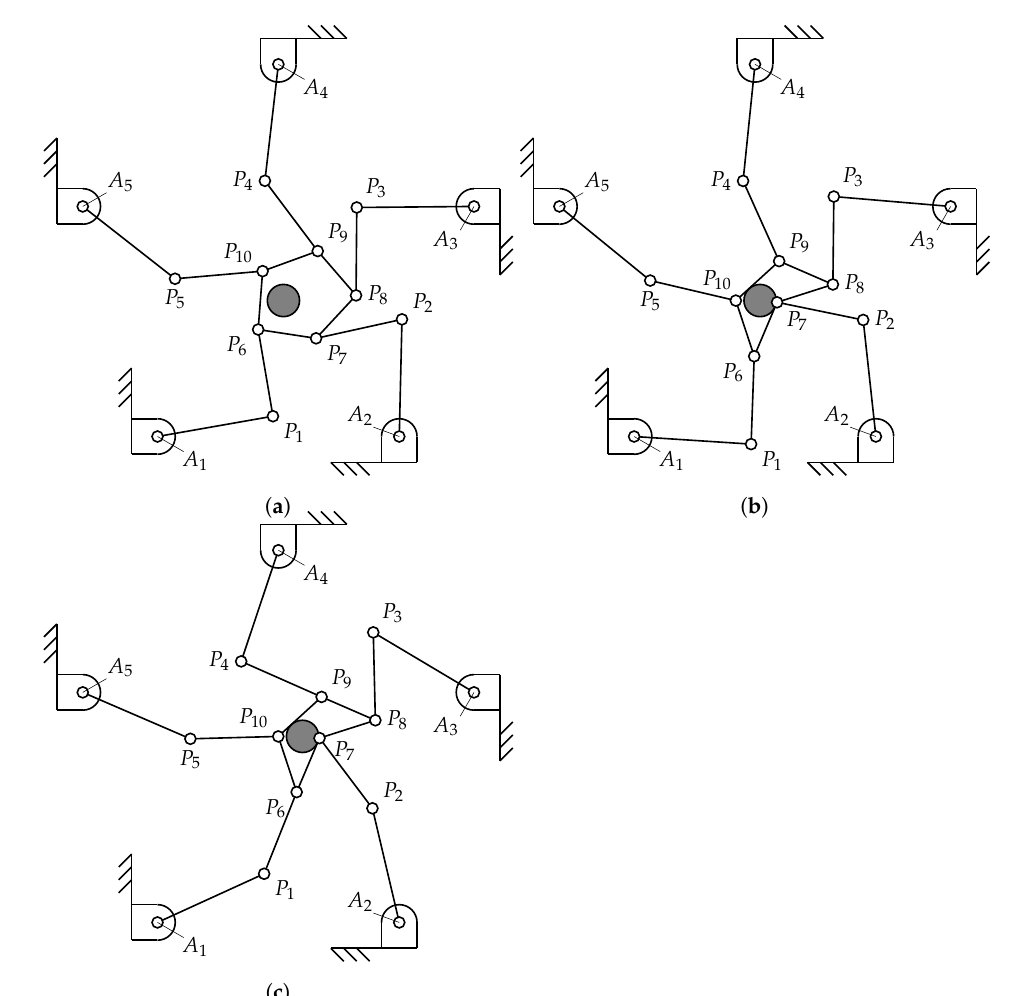
Figure 7. A schematic of a grasping motion with the prototype (see multimedia attachment): an object (in gray) is grasped by reconfiguring the EE and moved to a new pose in the plane, through three successive poses ( a – c